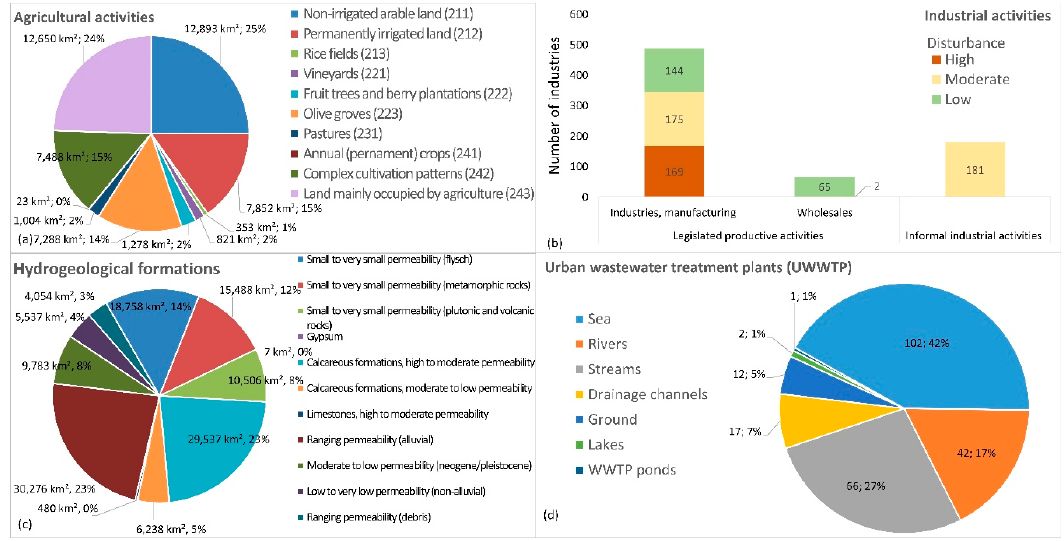
Figure 1. ( a ) Agricultural activities, ( b ) industrial activities, ( c ) hydrogeological structure, and ( d ) urban wastewater treatment plants of Greece.